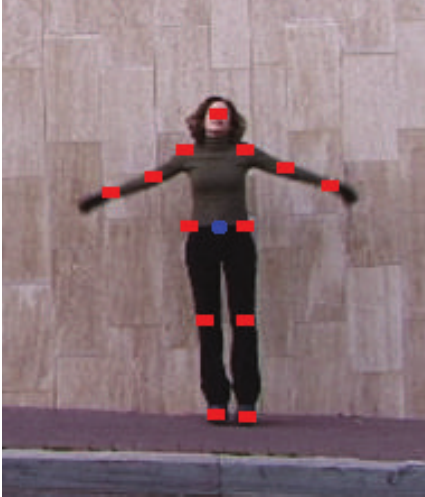
Figure 1: The human joints model. The original photo stems from Weizmann dataset